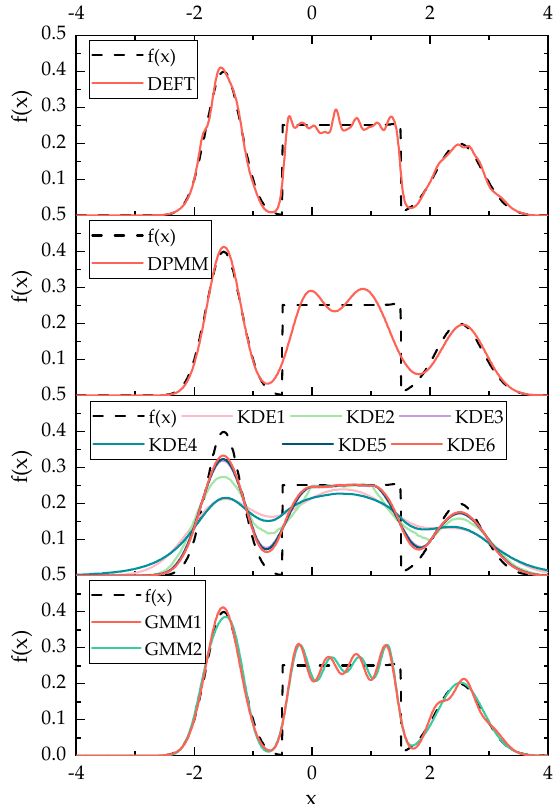
Figure 9. The JSD results of fitting 50 random datasets of size 1000, 5000, 10,000 generated from f ( x 2 ) T represents the average cost time of fitting 50 random datasets of size 10,000.